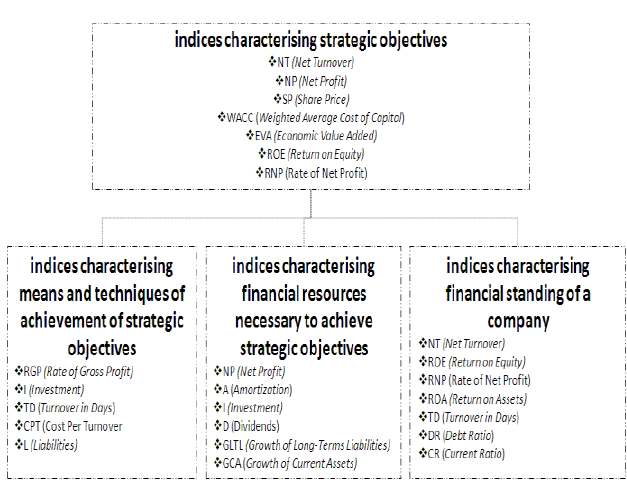
Fig. 1. The system of coherent financial indices (Savina,